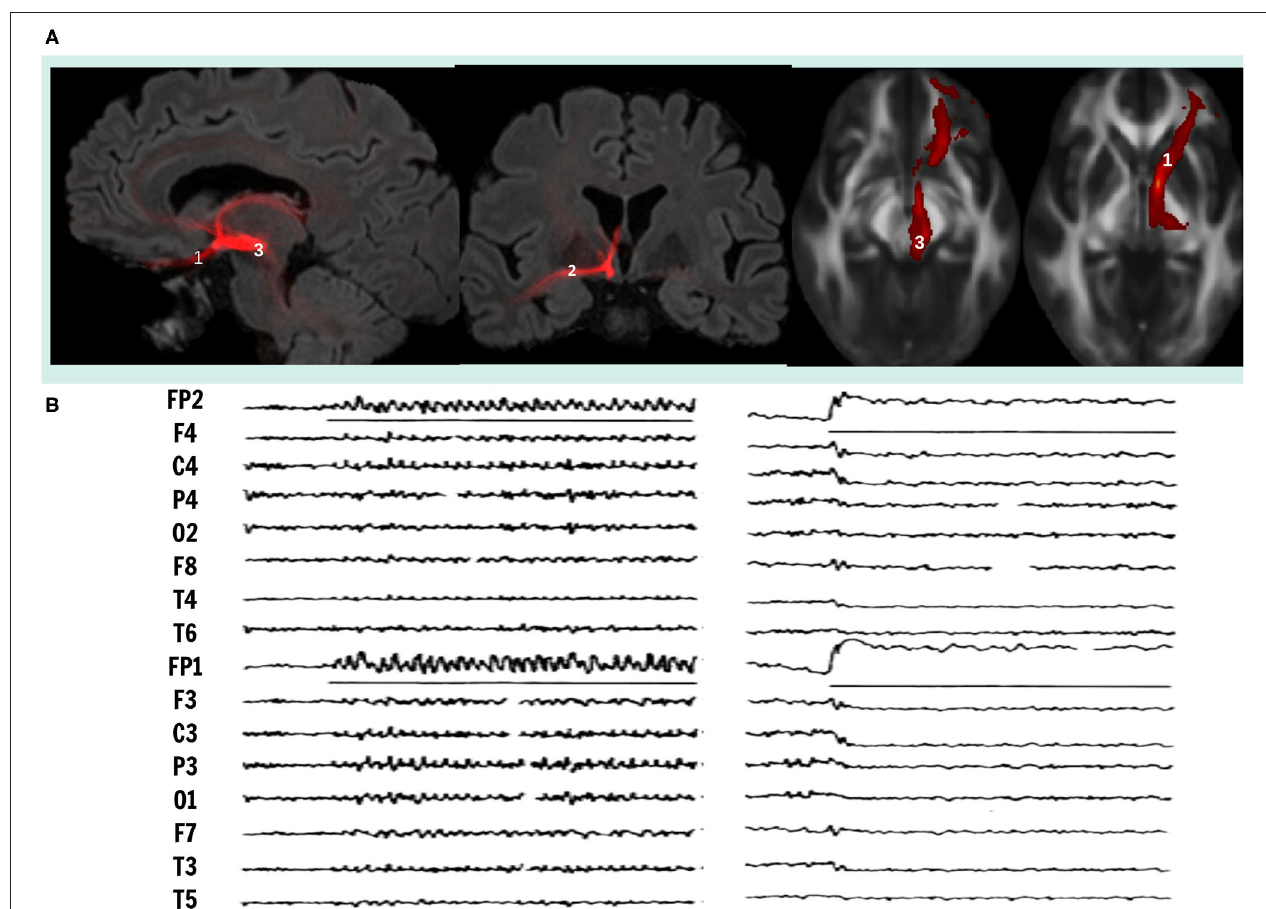
FIGURE 1 | (A) Visualization of white matter fiber bundle using probabilistic tractography, that connects orbitofrontal cortex with mesencephalic structures, superimposed to MRI sections in sagittal (left), coronal (center) and axial (right) views. Neuromodulation targets in DBS therapy in research for OCD and TRD, 1, Inferior Thalamic Peduncle; 2, Stria Terminalis; 3, Middle Forebrain Bundle. (B) On the left, electrocortical potentials induced recruiting responses by low frequency stimulation (8Hz, 450 µ s, 6.0V.) and on the right, desynchronization induced by high frequency stimulation (60Hz, 90 µ s, 3.5V.) on ITP, midline thalamic nuclei and OFC. Adapted from